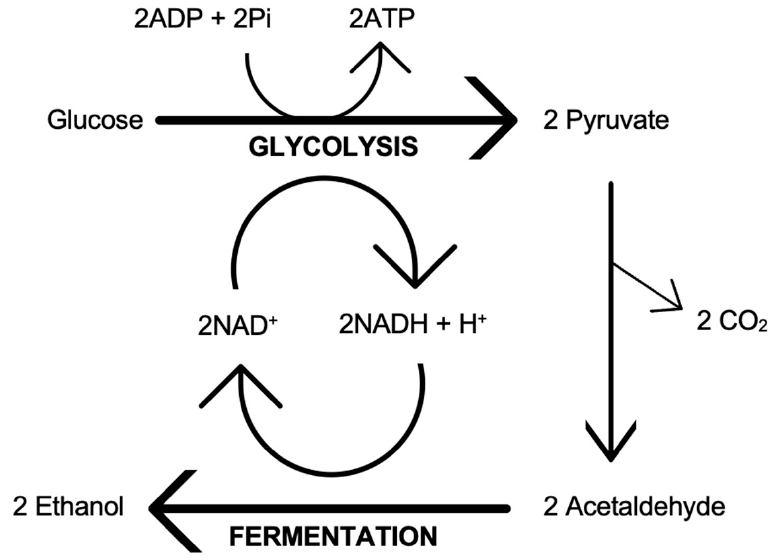
Figure 4. Summary of glycolysis and fermentation.